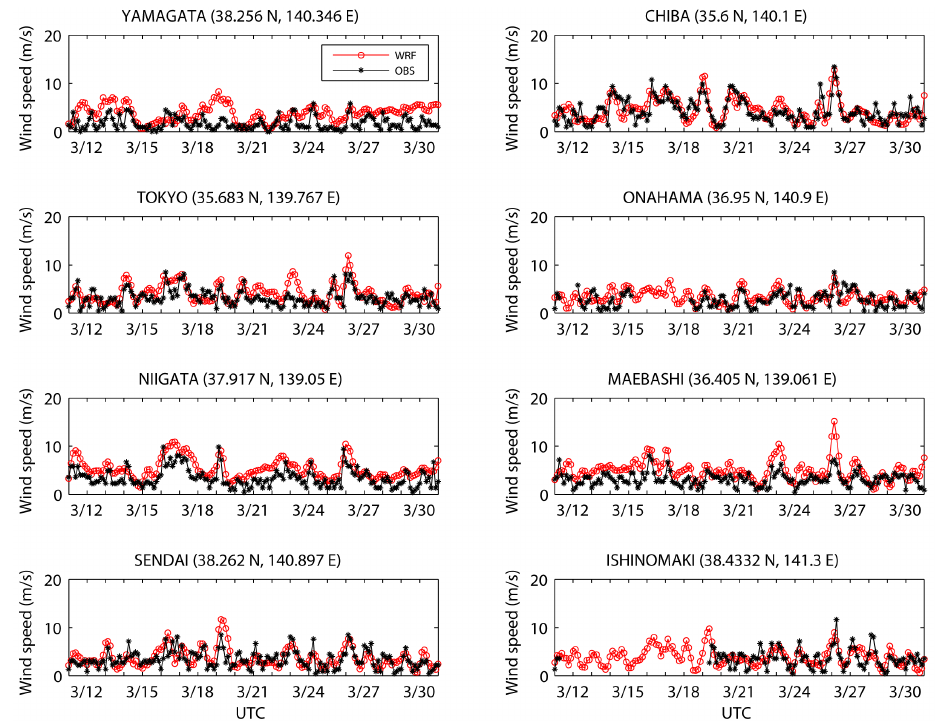
Figure 3. Simulated and observed surface wind speeds at eight stations over Japan during the period from 00:00UTC, 11 March to 00:00UTC, 31 March 2011 (case REF). Output from the simulation is collected every 1 hour, but we only display on the figure data with 3h resolution for clarity. Red circles represent the simulated data from WRF and the black asterisks represent the observed